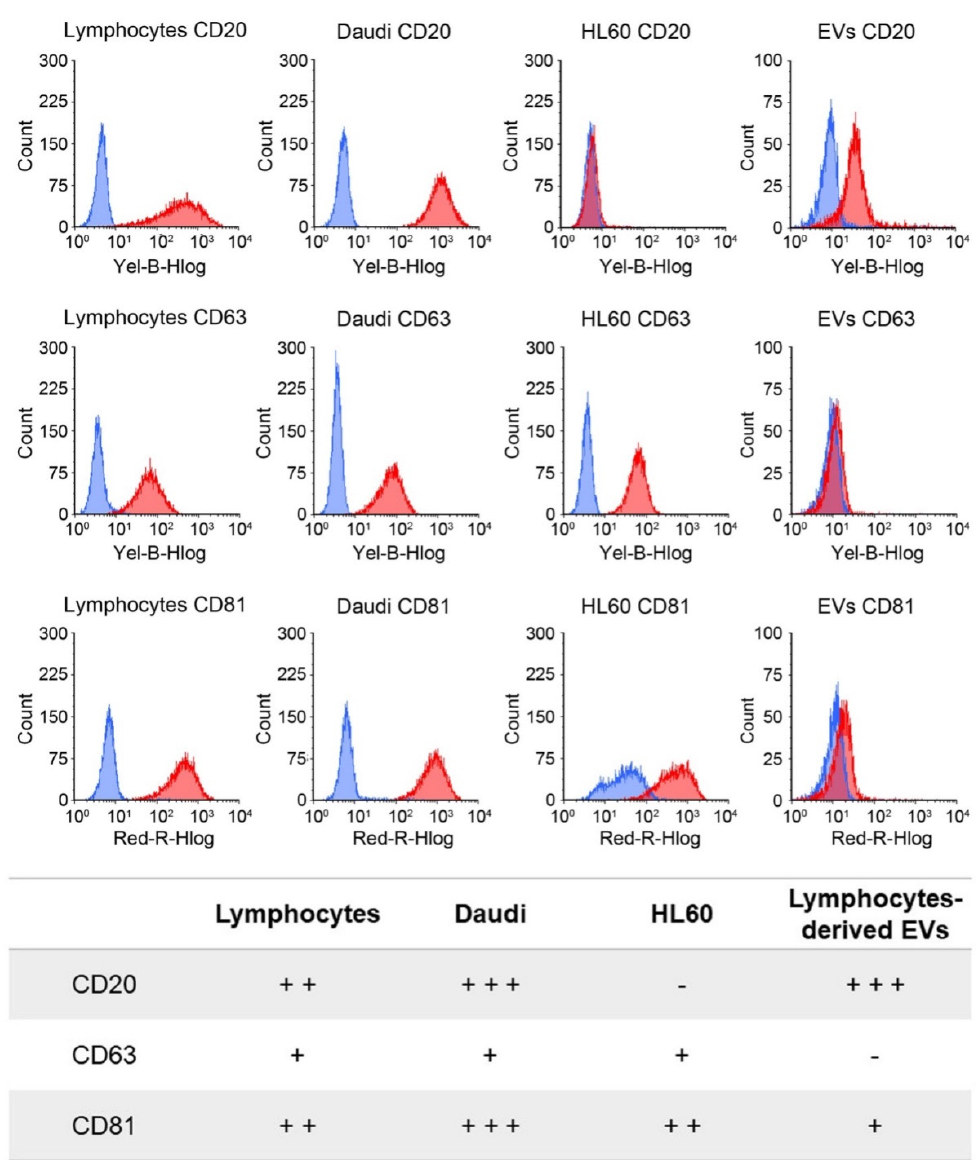
Figure 3. Cytofluorimetric evaluation of CD20, CD63, and CD81 marker expression levels on the plasma membrane of the three different cell lines and on the lymphocyte-derived EV membranes. In the upper panel, representative histograms of the expression of the different markers are reported for lymphocytes, Daudi, HL60, and EVs (blue represents the isotype controls, and red represents the related tested antigen). In the lower panel, the expression levels are grouped into negative (–), low (+), intermediate (++), and high (+++) categories, corresponding to the following signal intensities: <10, 10–100, 100–500, and 500–1,000, respectively, for cells and <1.5, 1.5–5, 5–10, and 10–20 for EVs.